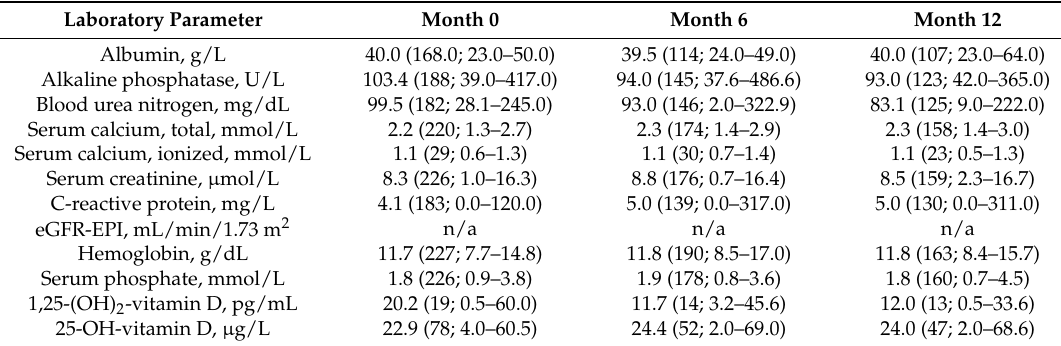
Table 14. Relevant laboratory data from dialysis patients with cinacalcet co-medication